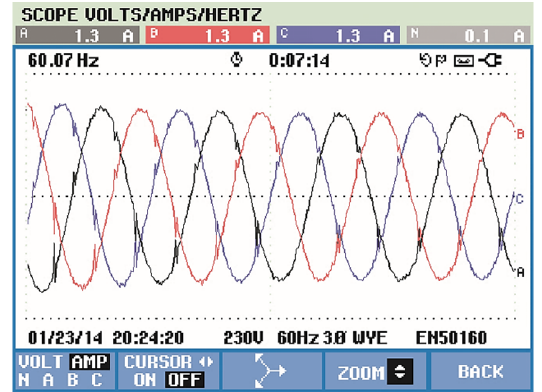
Figure 22. Source current with smart meter active compensation.